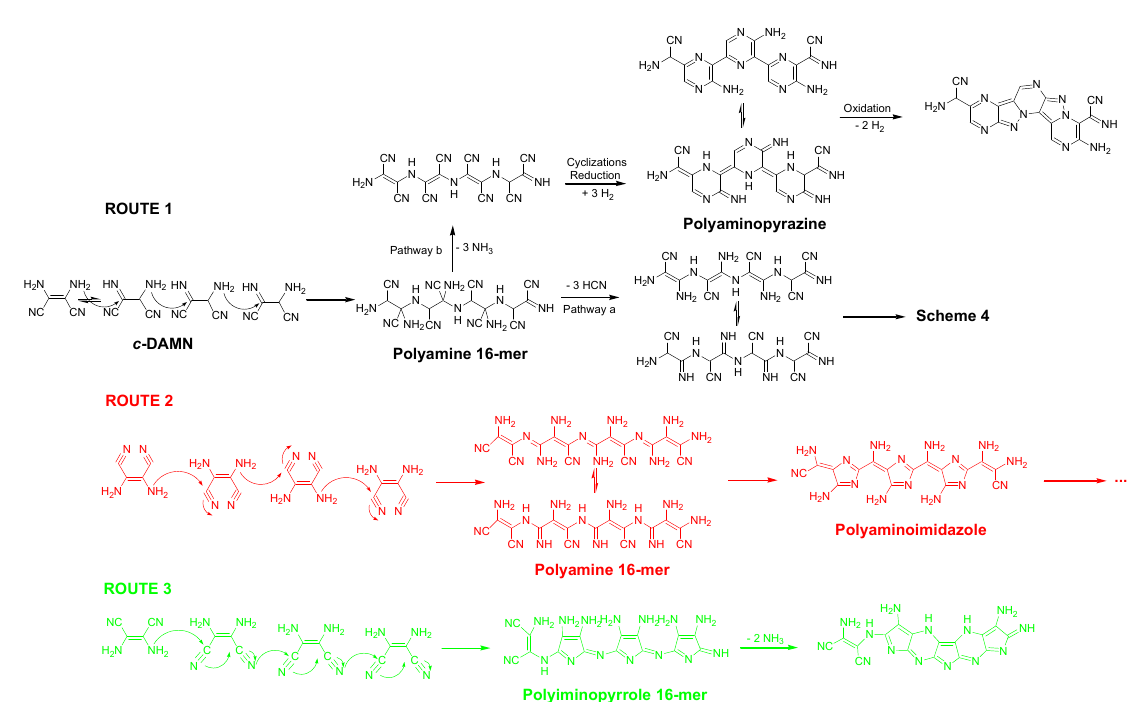
Scheme 5. Hypothetical pathways for the formation of HCN polymers from DAMN according to recent works in the literature.